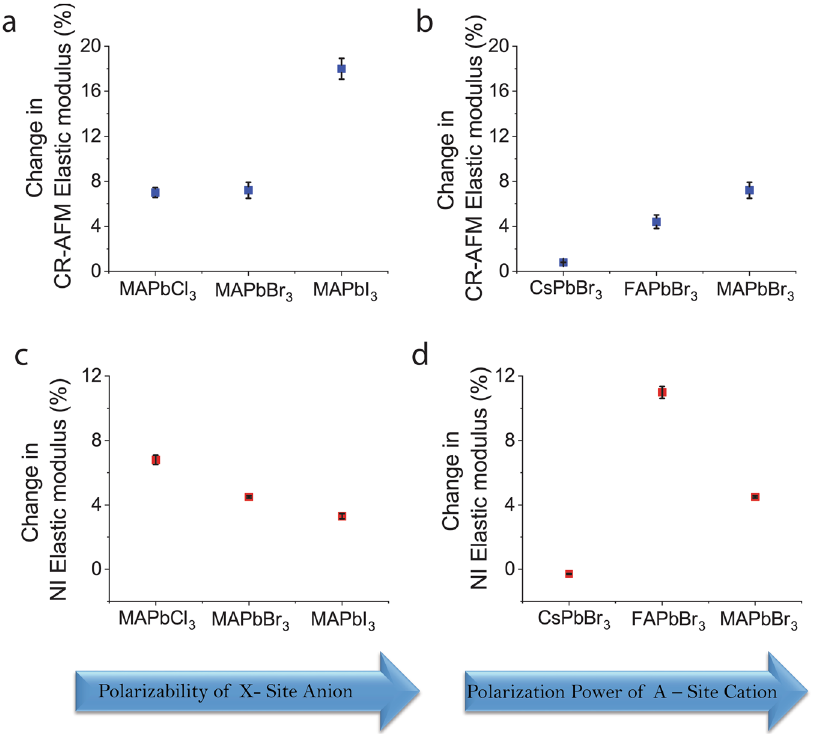
Fig. 3 In fl uence of ion polarization power/polarizability on modulus. Percentage change in E from CR-AFM (contact resonance) ( a , b ) and NI (nano- indenter) ( c , d ) between dry and humidity-exposed crystals, as function of X-site anion polarizability ( a ), ( c ), and as function of polarity of A-site cation ( b ), ( d ). Error bars are computed from the relative error of the quotient, using standard deviation of individual